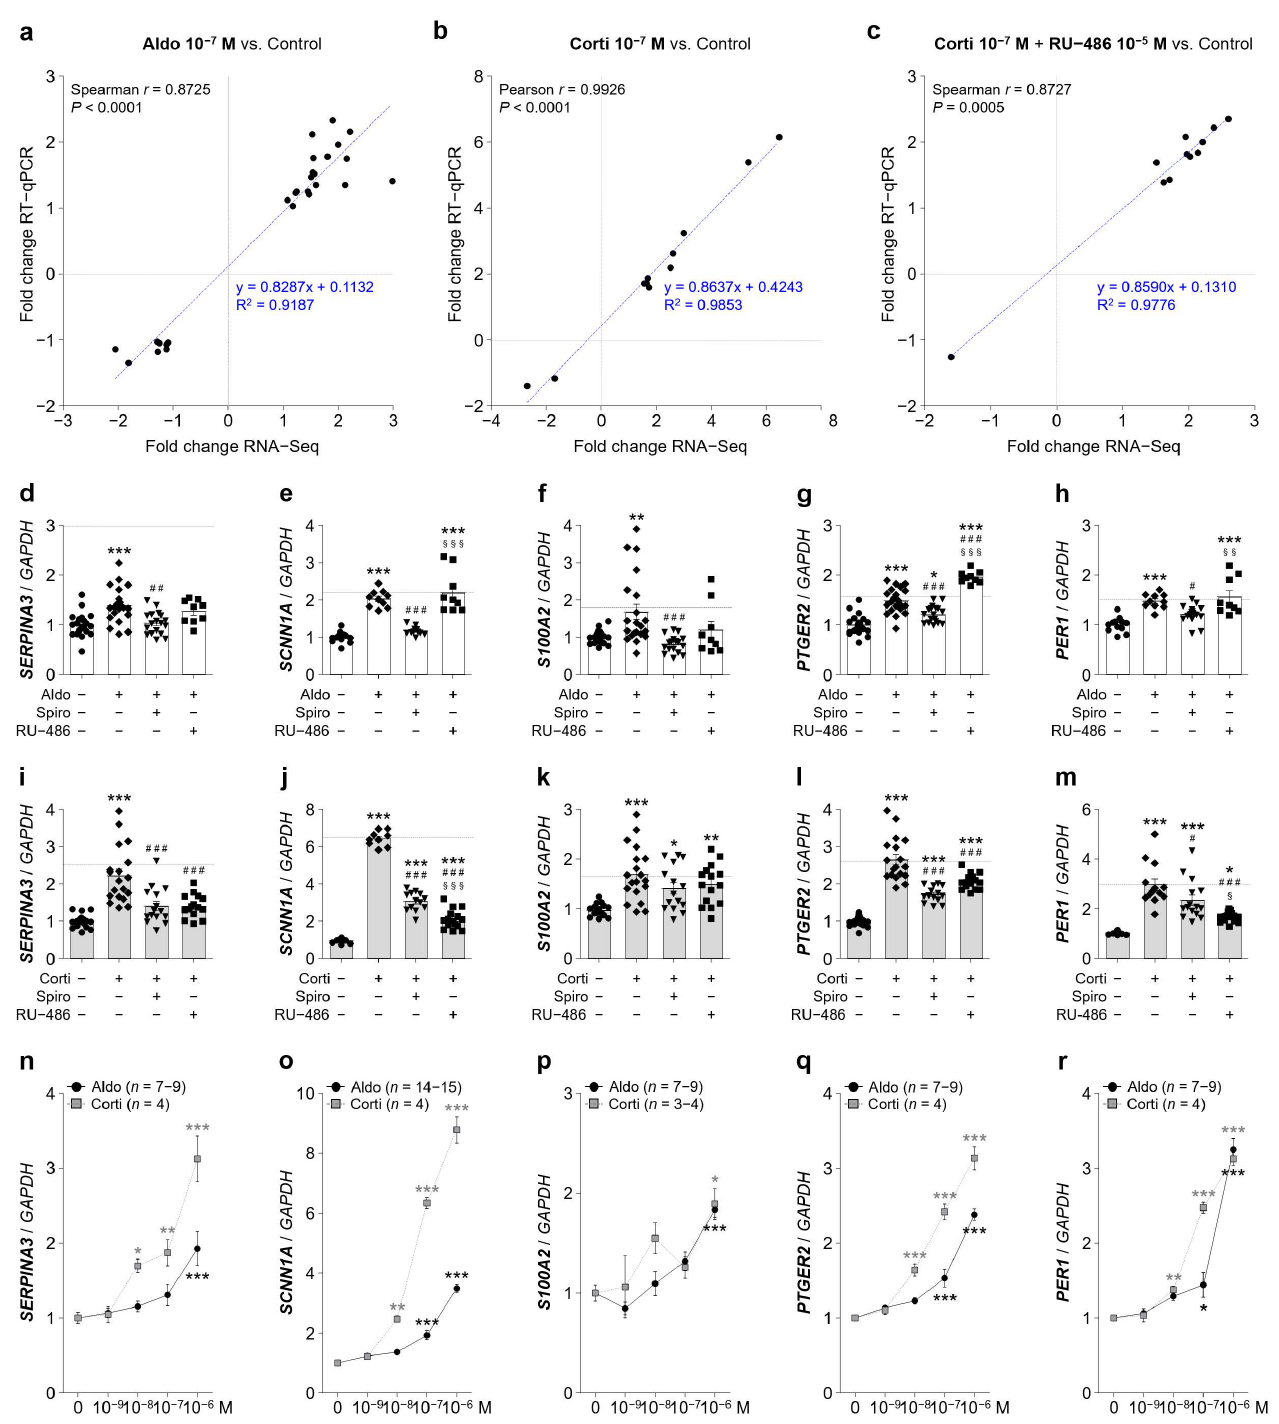
Figure 5. Aldosterone and cortisol up-regulated genes as predicted in RNA-Seq tested by RT-qPCR for validation. ( a – c ) Gene expression correlation analysis between RNA-Seq and RT-qPCR results generated in iRPE cells for the 3 experimental treatments aldosterone (aldo) 10 − 7 M ( a ), cortisol (corti) 10 − 7 M ( b ) and cortisol 10 − 7 M + RU-486 10 − 5 M ( c ). The Spearman’s rank correlation or Pearson’s correlation coefficient and the linear regression line (dashed blue line) are indicated. ( d – h ) Quantification by RT-qPCR of SERPINA3 ( d ), SCNN1A encoding α -ENaC ( e ), S100A2 ( f ), PTGER2 ( g ) and PER1 ( h ) mRNA expression relative to GAPDH in iRPE cells following 24 h treatment of aldosterone 10 − 7 M ±